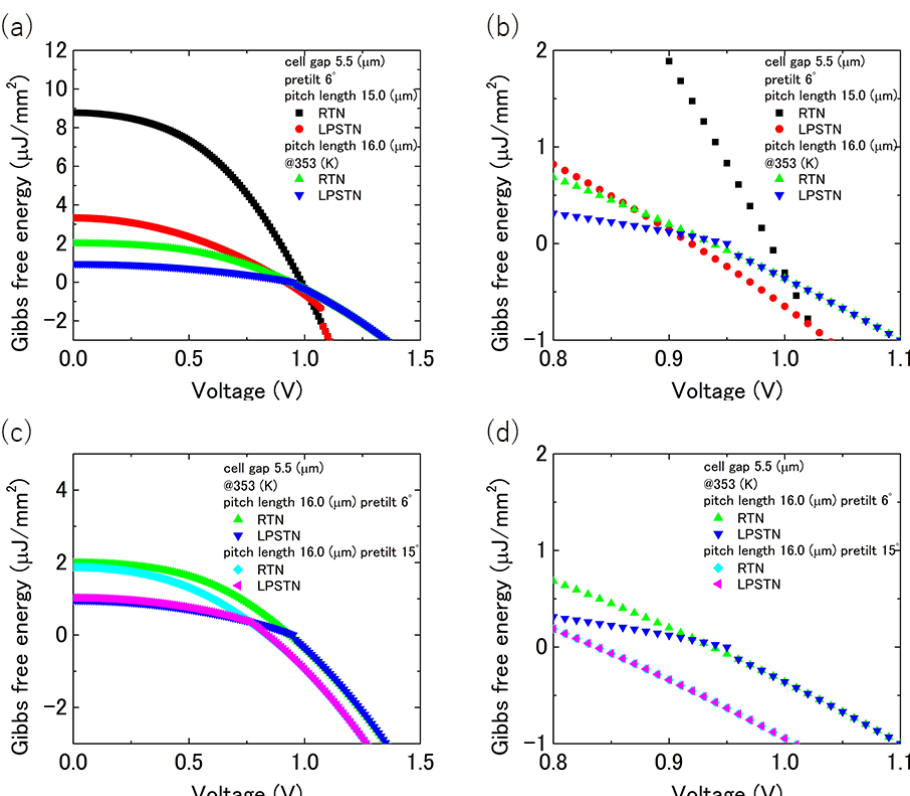
Figure 10. Gibbs free energy for the RTN and the LPSTN structures with a cell thickness of 5.5 µm ( a ) at 298 K or those at 353 K ( c ) at 353 K with a pretilt angle of 6° or 15° (lower left), and ( b , d ) ( a ) at 298 K or those at 353 K ( c ) at 353 K with a pretilt angle of 6 ◦ or 15 ◦ (lower left), and ( b , d ) enlarged enlarged views of the left-hand panels near 1 V. views of the left-hand panels near 1